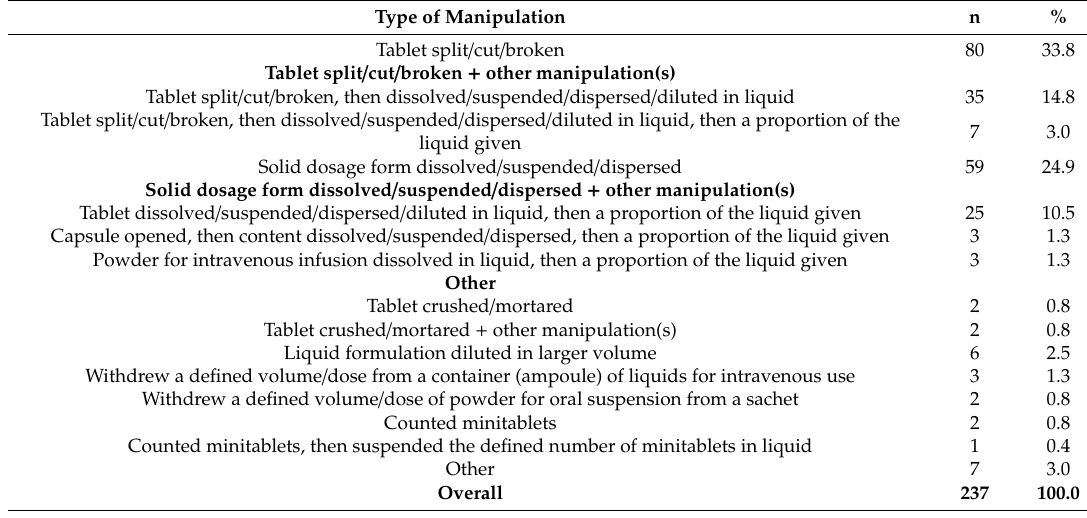
Table 4. Numbers of type of manipulation observed in this